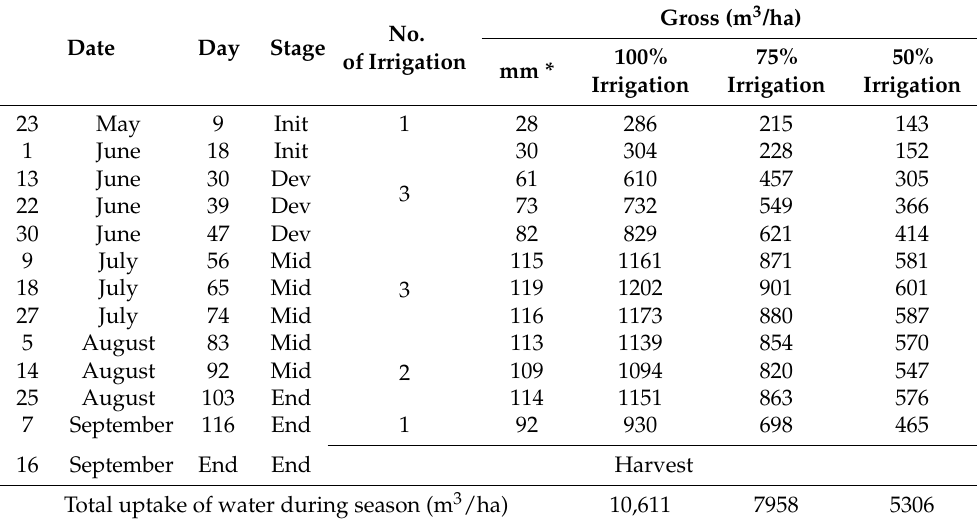
Table 4. Water irrigation scheme of field